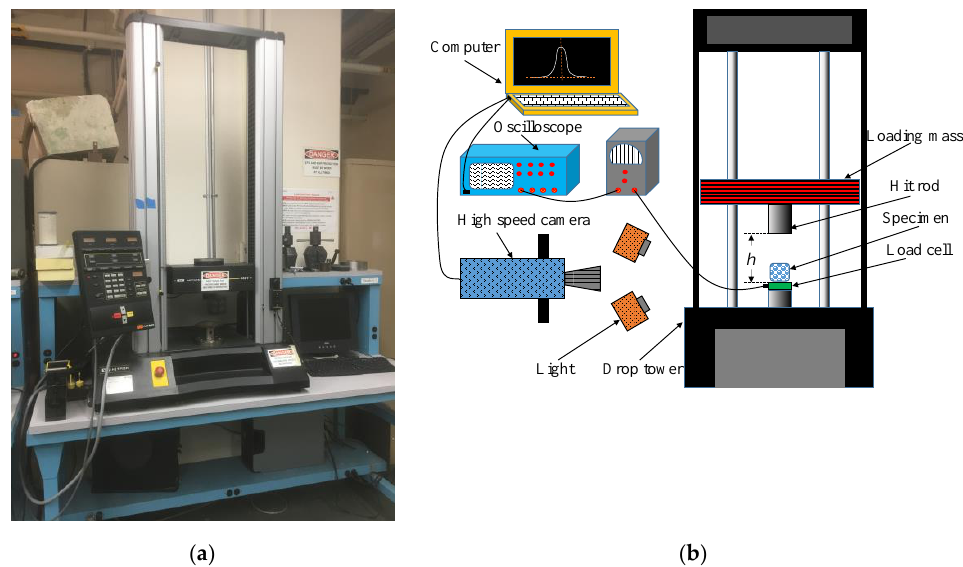
Figure 4. The experimental testing platform for foam materials: ( a ) the hydraulic testing machine corresponding to the quasi-static strain rate test; ( b ) the drop tower testing machine corresponding to the intermediate strain rate test.